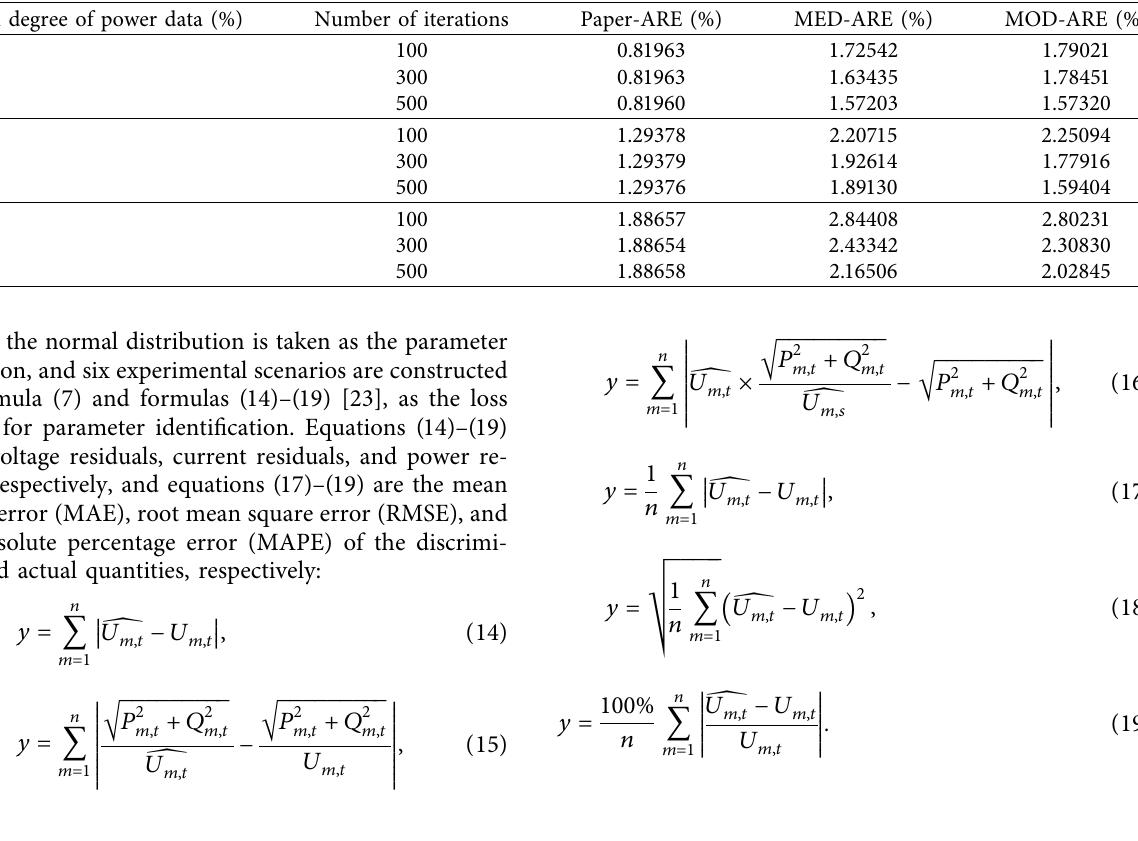
Table 6: Antinoise ability of algorithm (voltage